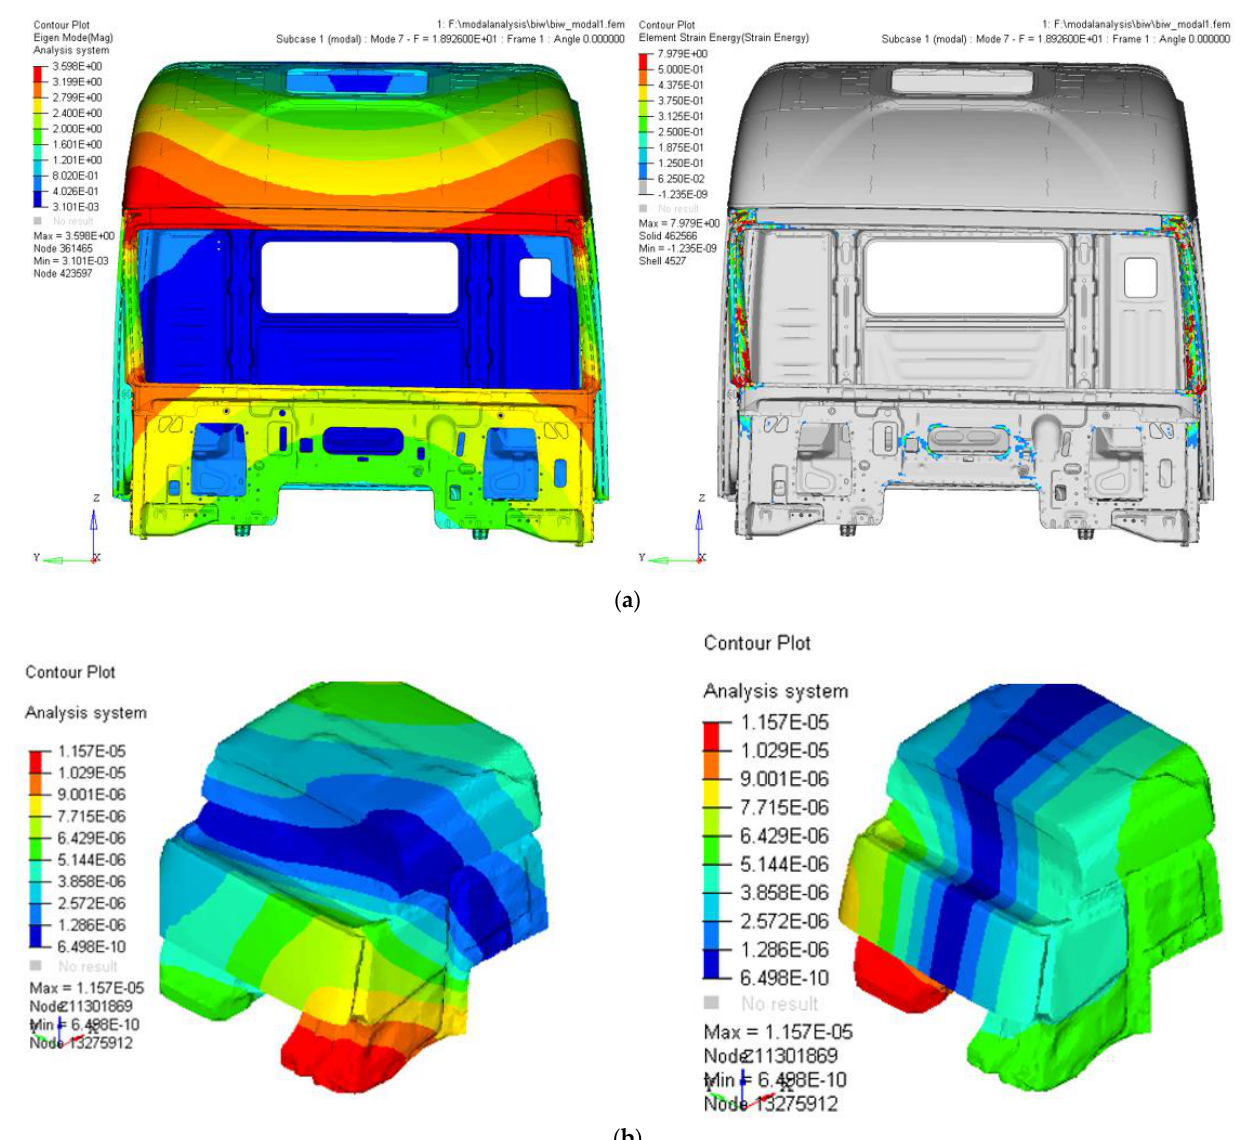
Figure 1. Finite element model of the commercial vehicle cab. ( a ) Commercial vehicle finite element modal model. The left ruler represents modal displacement, the right ruler represents modal strain energy, and the color gradient represents changes in modal displacement and strain energy. ( b ) Modal model of commercial vehicle acoustic cavity. The left ruler represents the modal shift, the right ruler represents the modal shift, and the color gradient represents the modal shift change.